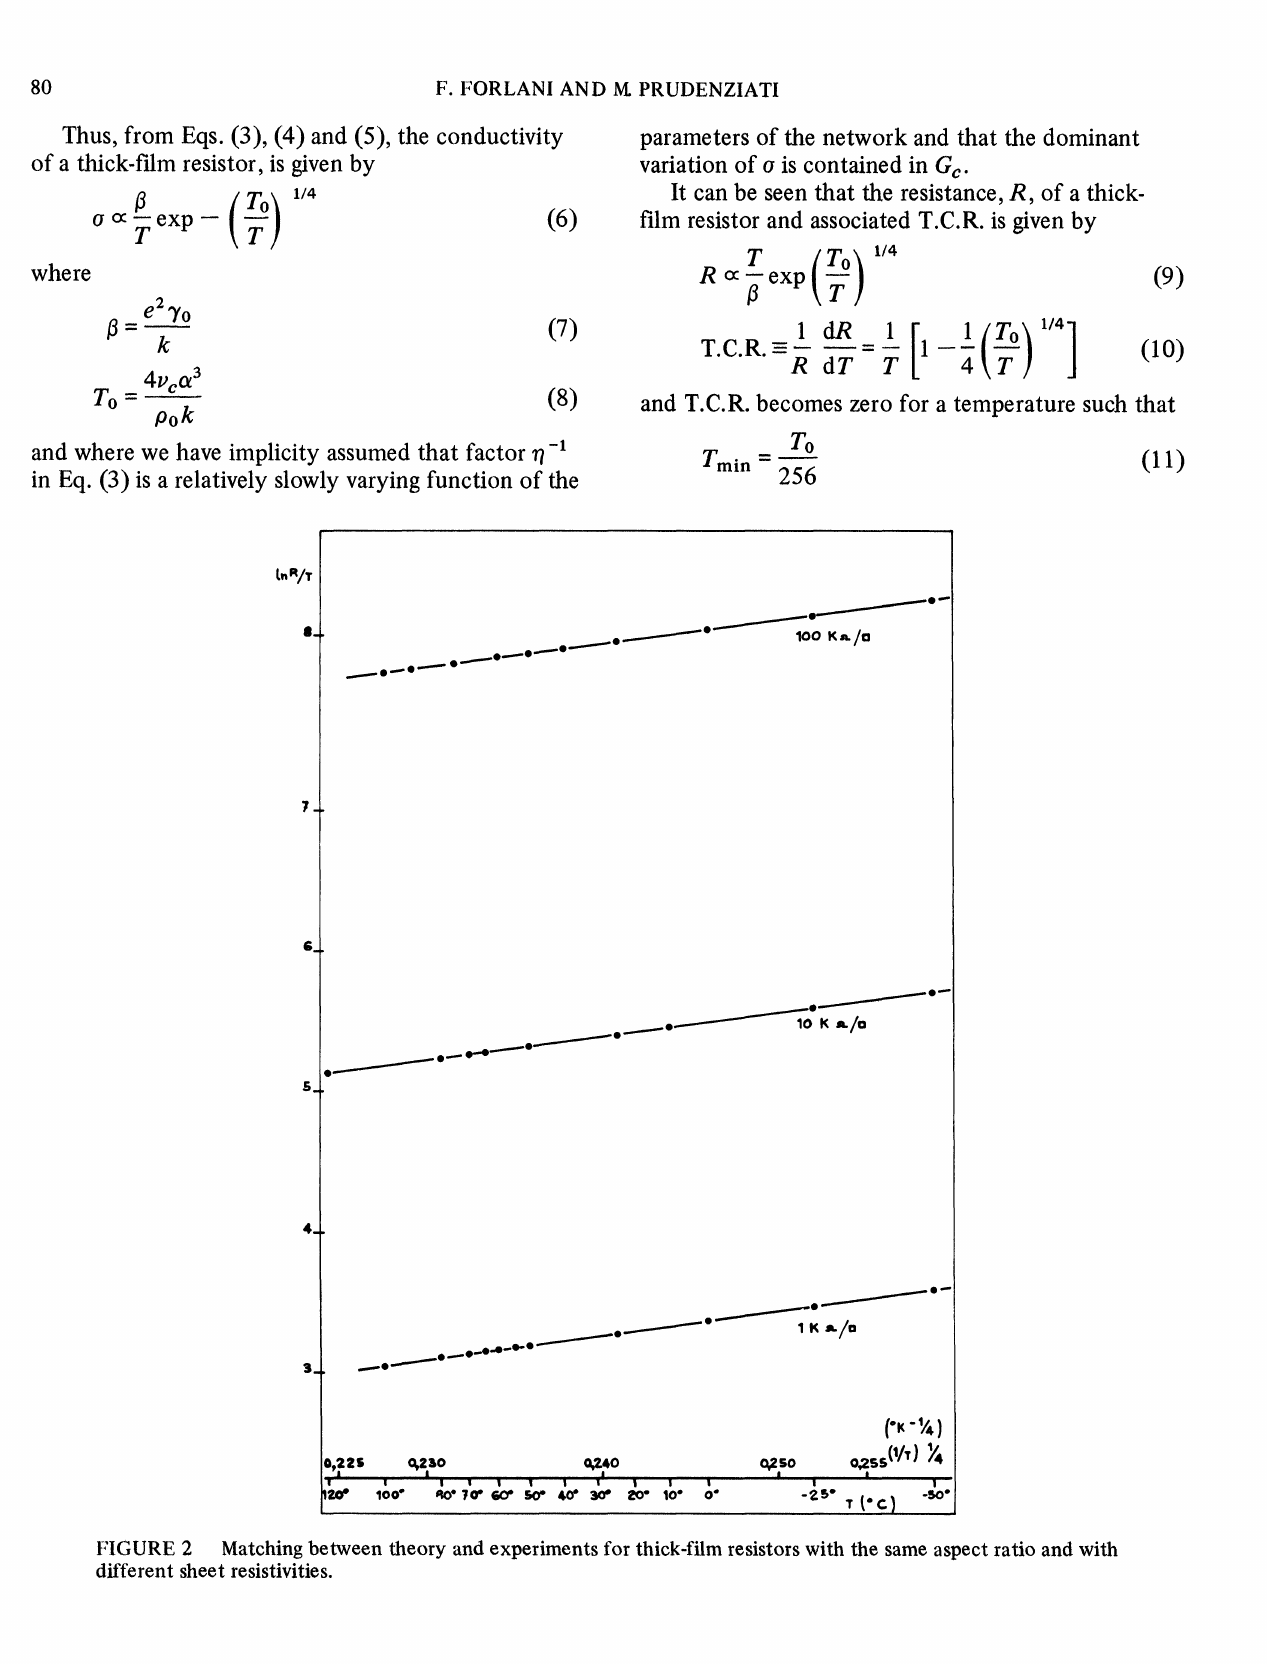
Matching between theory and experiments for thick-film resistors with the same aspect ratio and with different sheet